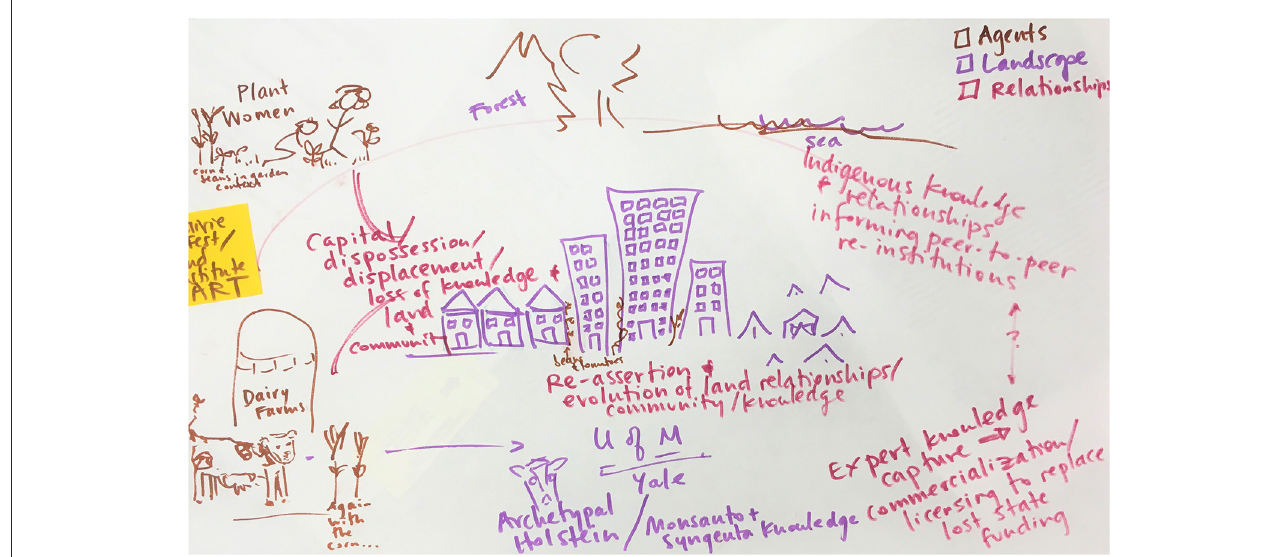
FIGURE2 Expanding our conception of relationships. During workshop 1, participants were asked to draw conceptual maps of their agroecology practice, including the people, groups, and beings involved in that practice. In this concept map, we see the ways that the more-than-human—beings (such as plants, forests, and animals) and land, water, and air—are being incorporated into the understanding of relationships, as well as the attribution of their inclusion to Indigenous knowledge and